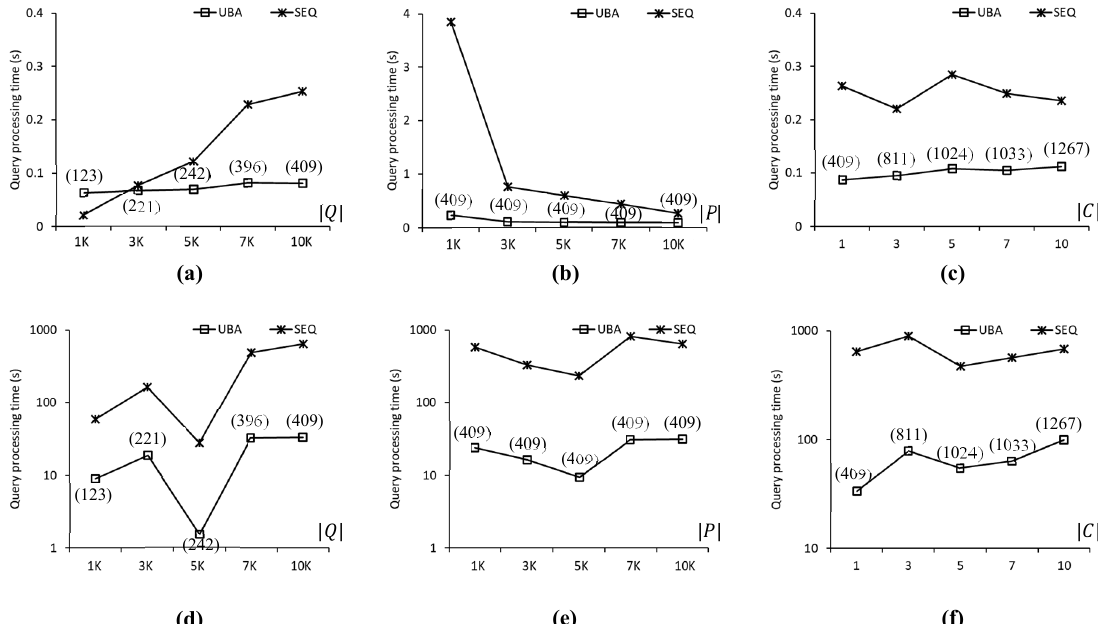
Figure 9. Comparison of query processing times for the COL roadmap: ( a ) 1 K ≤ | Q | ≤ 10 K. ( b ) 1 K ≤ | P | ≤ 10 K. ( c ) 1 ≤ | C | ≤ 10. ( d ) 1 K ≤ | Q | ≤ 10 K. ( e ) 1 K ≤ | P | ≤ 10 K. ( f ) 1 ≤ | C | ≤ 10.